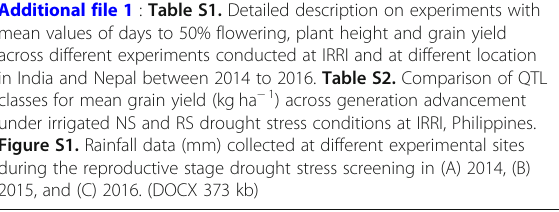
Additional file 1 : Table S1. Detailed description on experiments with mean values of days to 50% flowering, plant height and grain yield across different experiments conducted at IRRI and at different location in India and Nepal between 2014 to 2016. Table S2. Comparison of QTL classes for mean grain yield (kg ha − 1 ) across generation advancement under irrigated NS and RS drought stress conditions at IRRI, Philippines. Figure S1. Rainfall data (mm) collected at different experimental sites during the reproductive stage drought stress screening in (A) 2014, (B) 2015, and (C) 2016. (DOCX 373